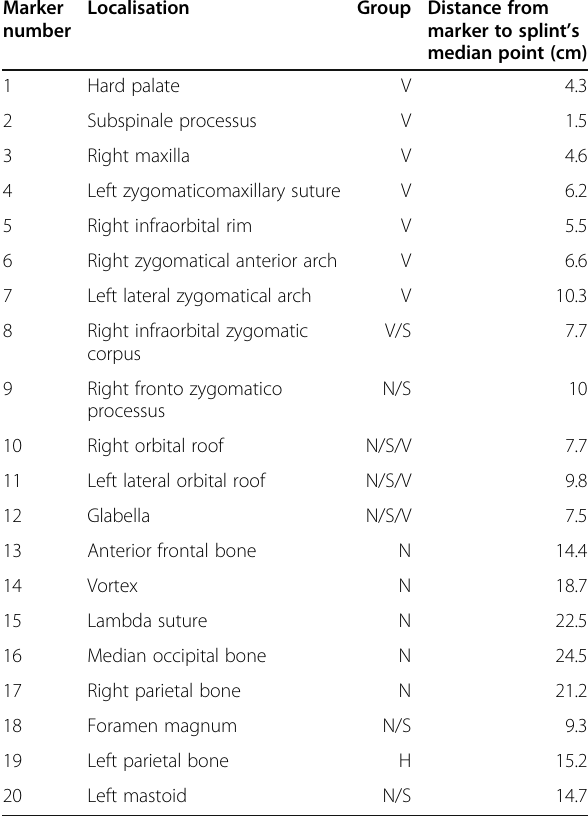
Table 2 Assignment of 20 bone markers to three head regions (viscerocranium “ V, ” neurocranium “ N, ” and skull base “ S ” )